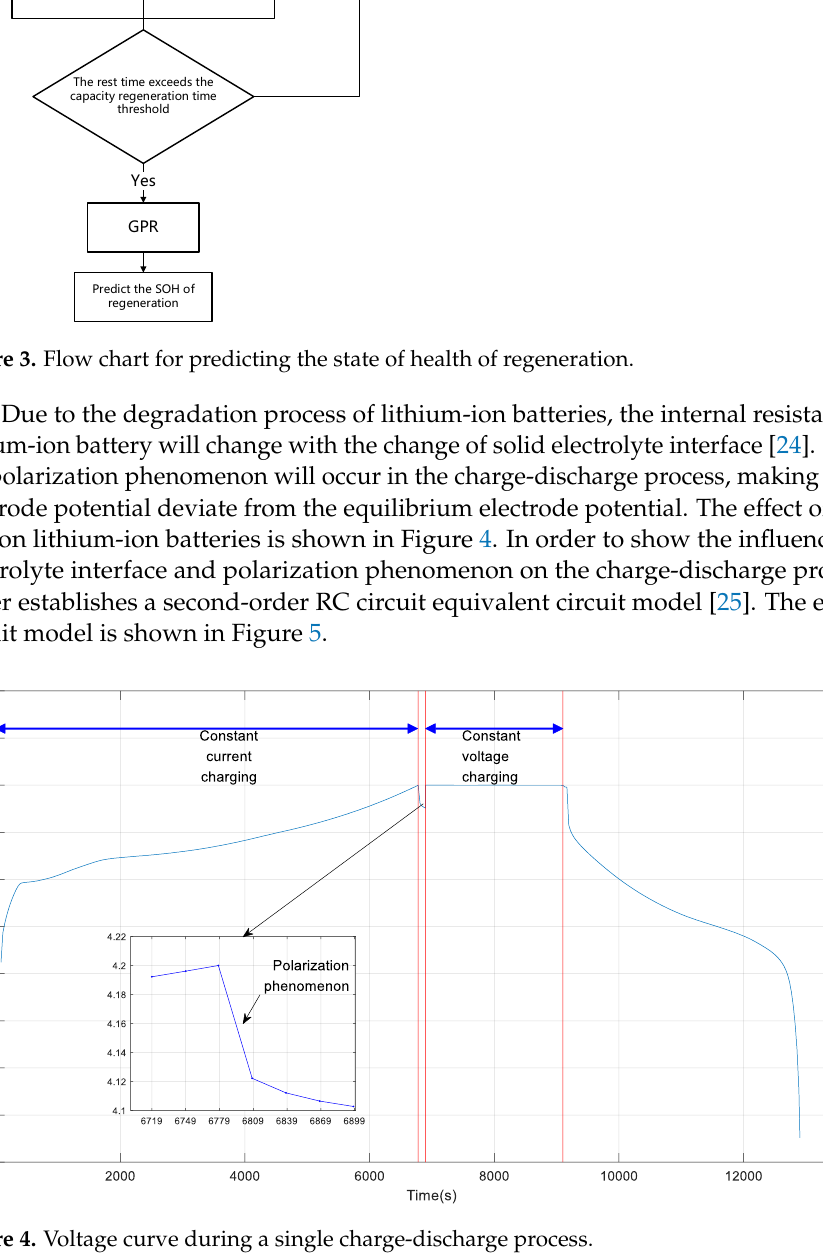
Figure 5. Internal equivalent circuit model of lithium-ion battery . In Figure 5, 𝑈 𝑜𝑐 represents the open-circuit voltage (OCV), which is affected by the current state of charge, 𝐼 𝐿 represents the charge-discharge current, 𝑅 0 represents the in- ternal resistance determined by solid electrolyte interface film, 𝑅 1 , 𝐶 1 represents the re- sistance and capacitance affected by electrochemical polarization, and 𝑅 2 , 𝐶 2 represents the resistance and capacitance affected by concentration polarization. The equivalent circuit equation is as follows. 𝑈 𝑜𝑐 (𝑆𝑂𝐶) + 𝐼 𝐿 𝑅 0 + 𝐼 𝐿 𝑅 1 (1 − 𝑒 − 𝑡 𝐶 1 𝑅 1 ) + 𝐼 𝐿 𝑅 2 (1 − 𝑒 − 𝑡 𝐶 2 𝑅 2 ) = 𝑈 𝐿 (3) Figure 6 shows the terminal voltage curve corresponding to the state of charge dur- ing the charge-discharge process. The terminal voltage will increase as the state of charge increases, and the process is nonlinear. However, due to the internal resistance, the termi- nal voltage is different during the charging and discharging process. Therefore, the fitting equation between state of charge and terminal voltage curve is established in this paper.